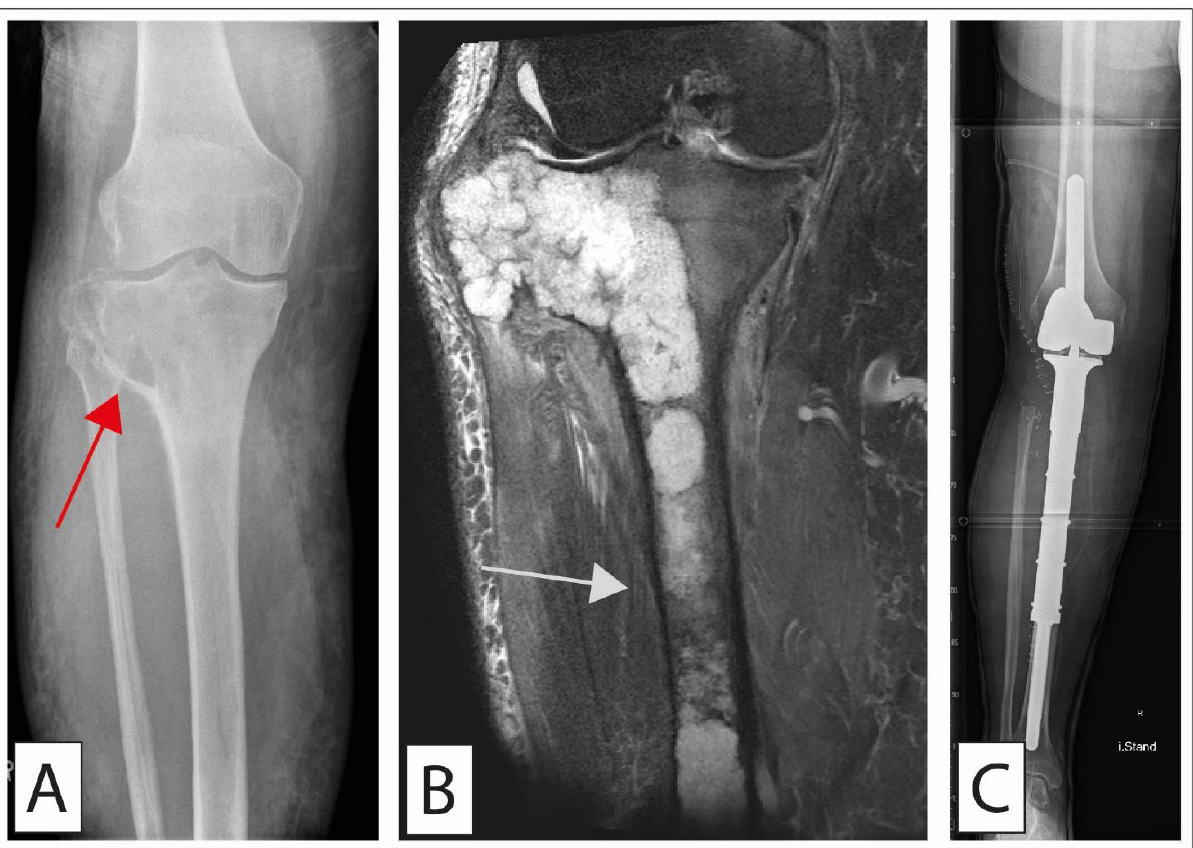
Figure 4. Chondrosarcoma treated with megaprosthesis. A 58-year-old patient presenting with a local prominence around the lateral knee. ( A ) Conventional radiographs showed an osteodestructive process in the region of the metaphysis affecting the bone cortex (red arrow). ( B ) A PDW-SPAIR MR coronal image illustrates the vast infiltration of the diaphysis distally (gray arrow). Open biopsy was performed, showing a highly differentiated chondrosarcoma (G1). Due to the destructive properties of this tumor, we performed complete resection (R0) and implanted a megaprosthesis matching the created defect (Implantcast, MUTARS proximal tibia) ( C ). A gastrocnemius and a soleus flap were performed to cover the foreign material at the site of the former tibia. The aponeurosis of the gastrocnemius was sutured on the patella tendon for additional stability of the extensor mechanism.